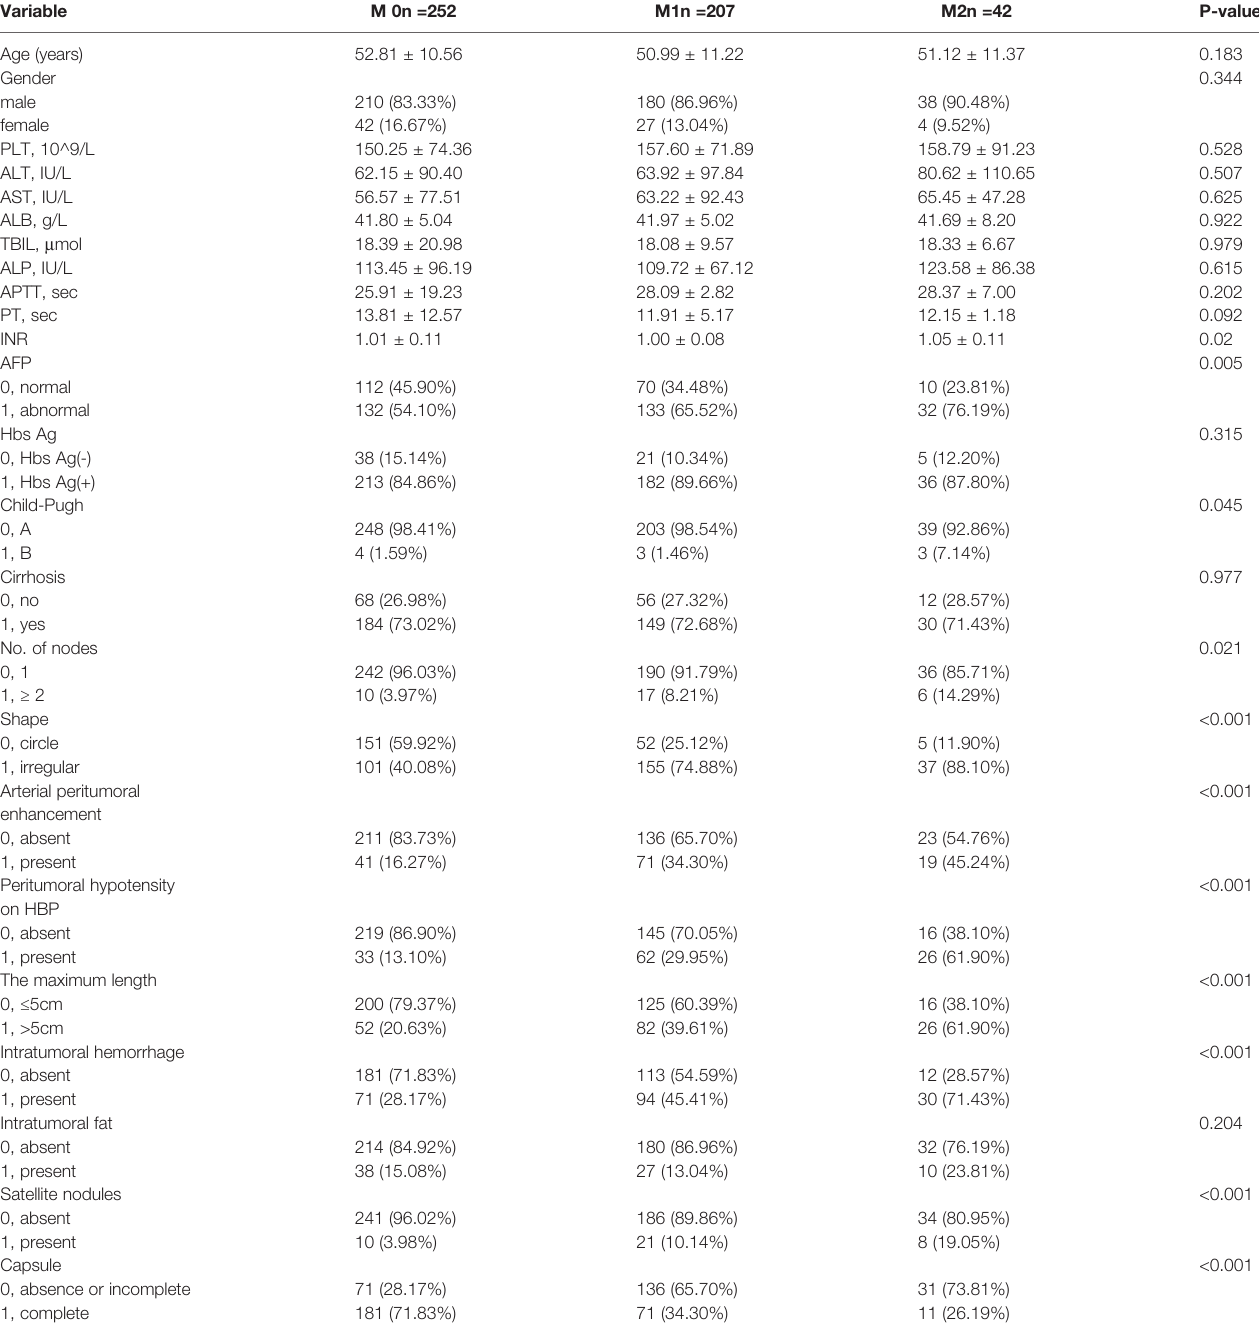
TABLE 1 | Comparisons of clinicoradiological characteristics in different microvascular invasion grades.